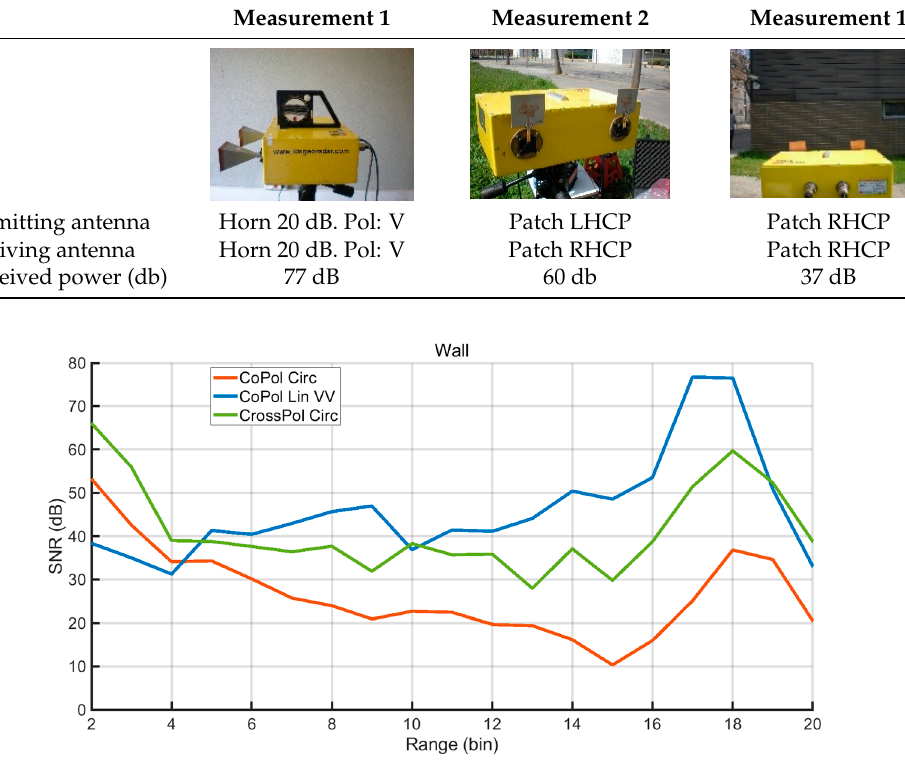
Figure 8. Range profile (1 bin = 0.5 m), obtained in front of a wall with three different polarization configurations: VV (green line), cross-pol circular (red line), co-pol circular (blue line).